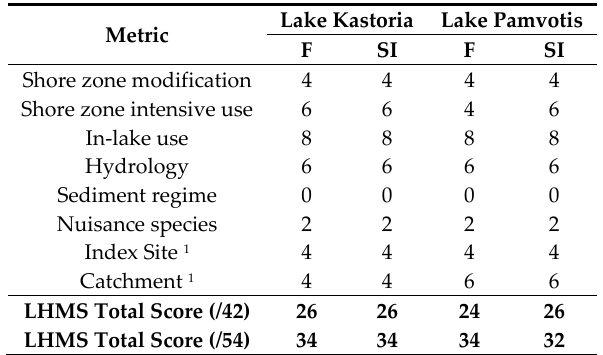
Table 3. Lake Habitat Modification Scores (LHMS) for each metric for lakes Kastoria and Pamvotis based on the different approaches (F: foot and SI: satellite